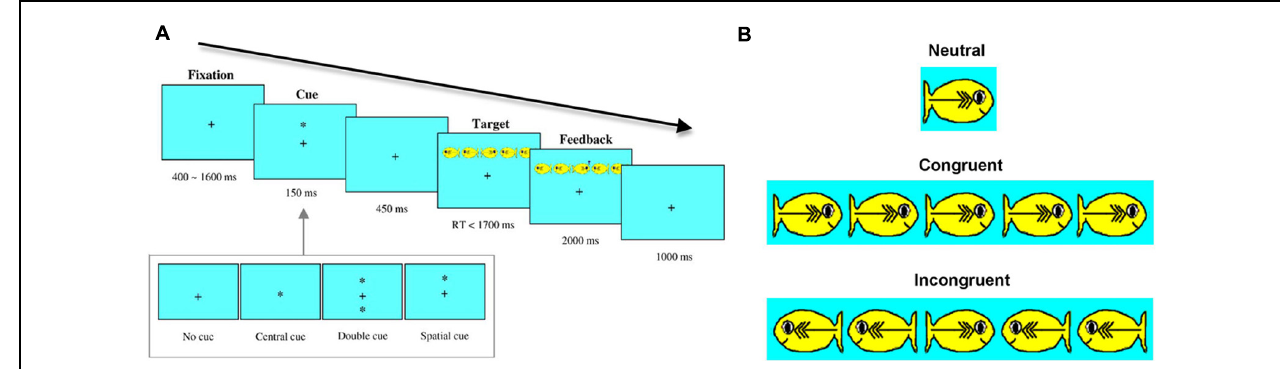
FIGURE 1 | (A) The Attention Network Test (ANT) task design, and (B) A set of stimuli used in the ANT. Figure retrieved from Rueda et al. (2004).